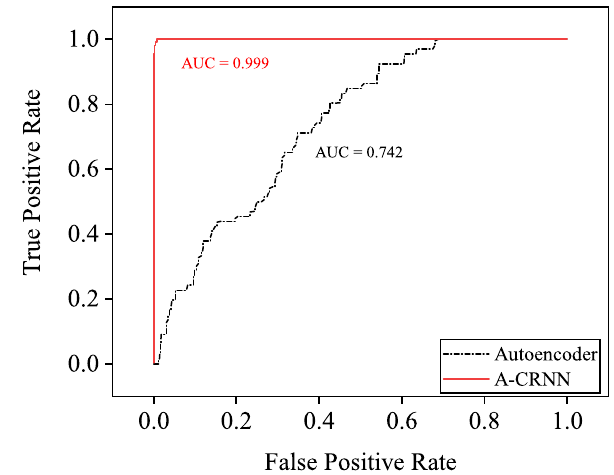
Figure 7. Receiver operating characteristic (ROC) curves of the autoencoder and the proposed A-CRNN spacial filter of independent two-source DOA estimation.